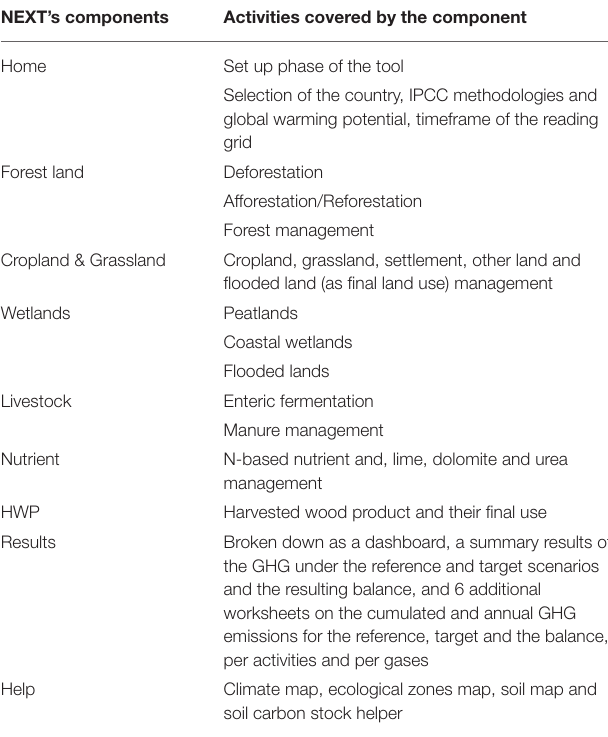
TABLE 1 | NEXT components and associated